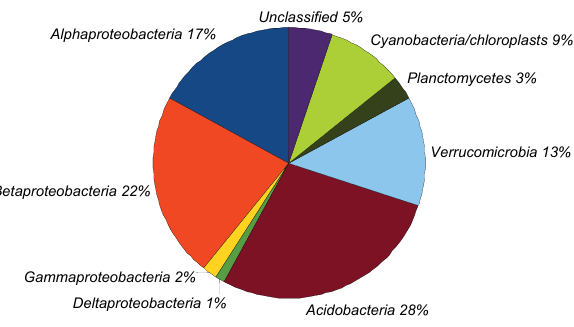
Fig. 2. Phylogenetic classification from two 16S rRNA clone li- braries from Patagonian Sphagnum